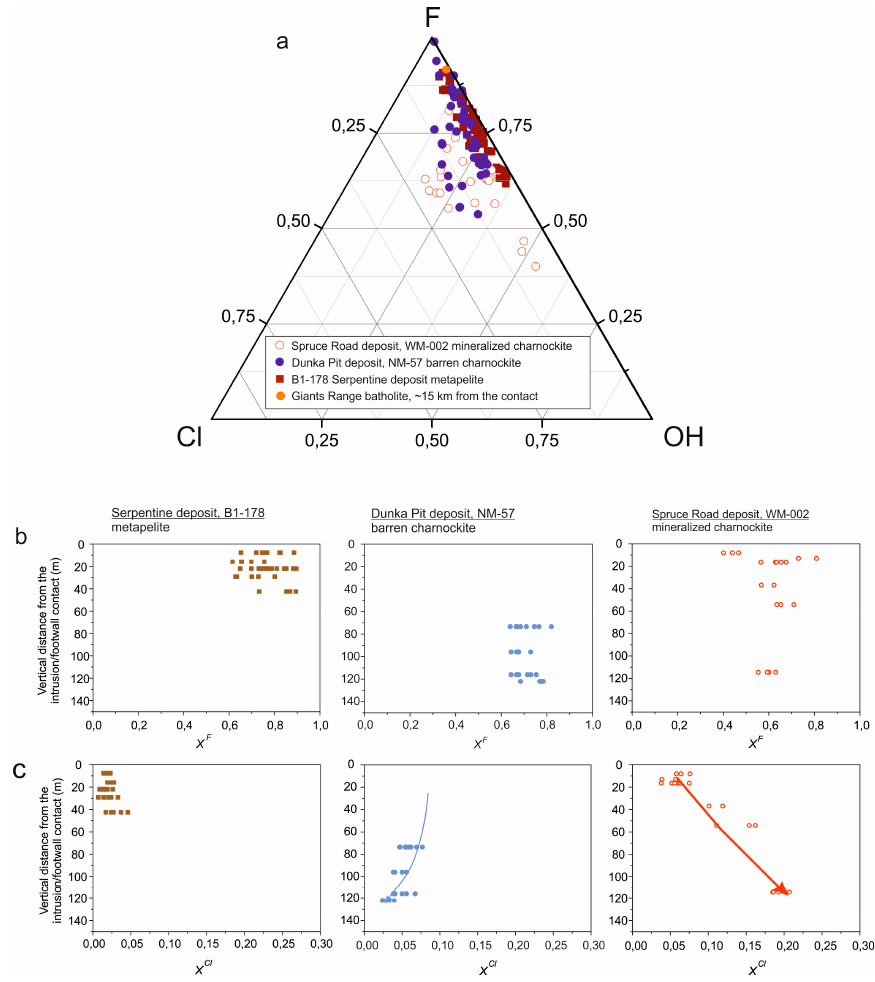
Figure 7. ( a ) Composition of apatite. ( b , c ) Depth versus mole fractions of Cl ( X Cl ) and F ( X F ) in apatite in the footwall of the studied drill cores. The top of the plots coincided with the intrusion-footwall contact. Note the two opposite trends: X Cl in the Serpentine and Spruce Road deposits increased with increasing depth, whereas it decreased in the Dunka Pit deposit in the NM-57 drill core.